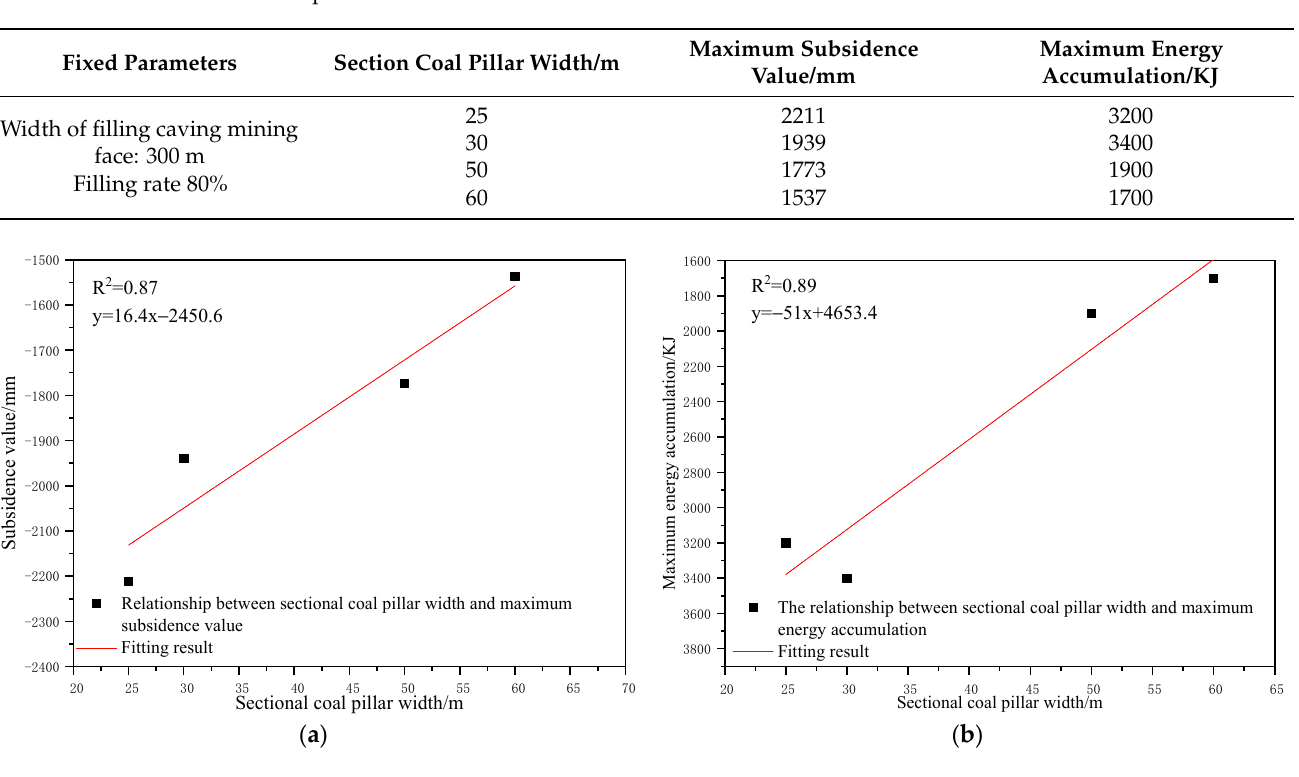
Figure 18. Influence of sectional coal pillar width on control effect of partial filling mining based on main key stratum; ( a ) Relationship between sectional coal pillar width and maximum subsidence value. ( b ) Relationship between sectional coal pillar width and maximum energy accumulation.